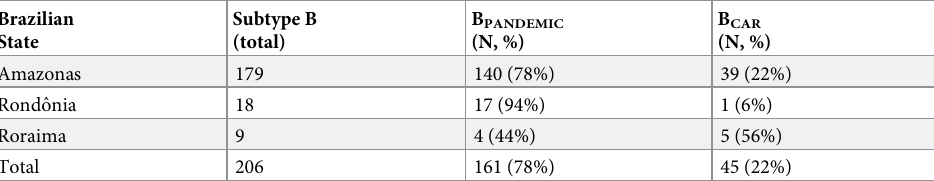
Table 2. Subtype B clade assignment: B PANDEMIC and B CARIBBEAN / B CAR . Brazilian